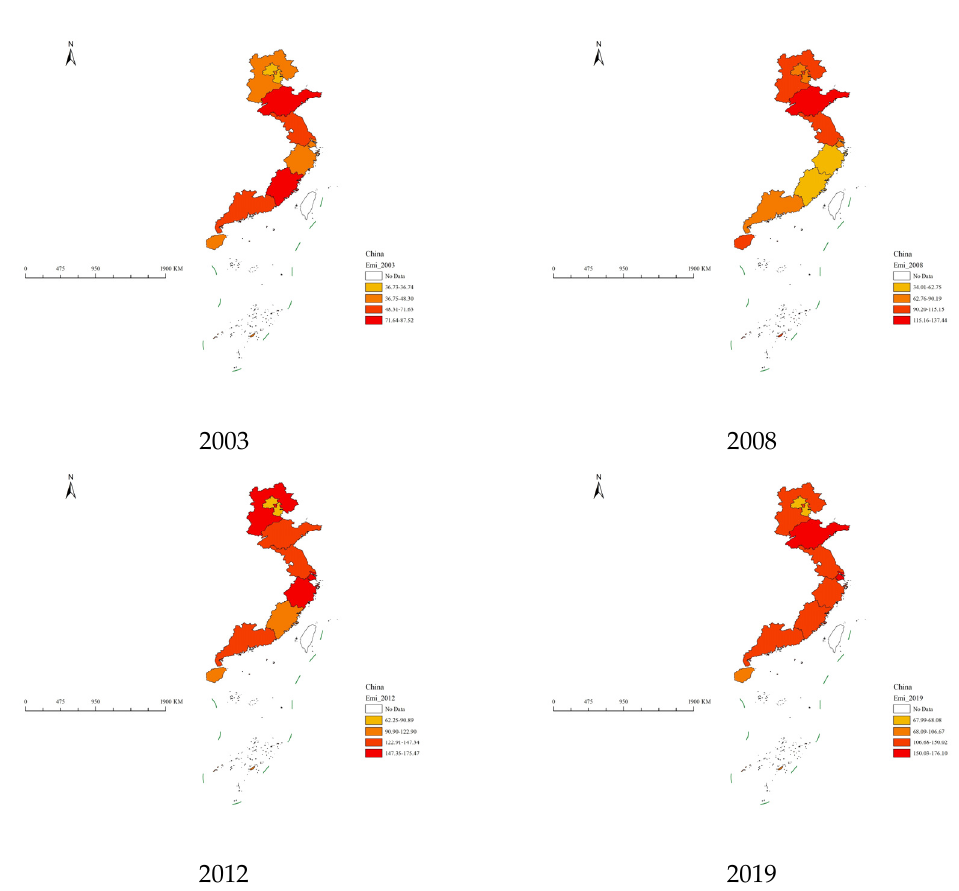
Figure 2. The level of market integration in eastern China.